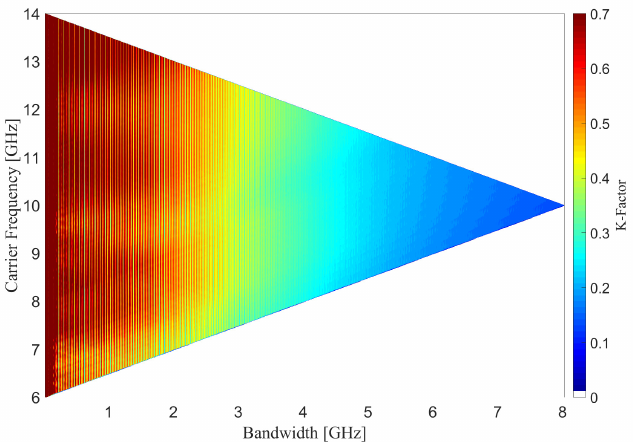
Figure 10. The K-Factor versus carrier frequency and bandwidth at Position